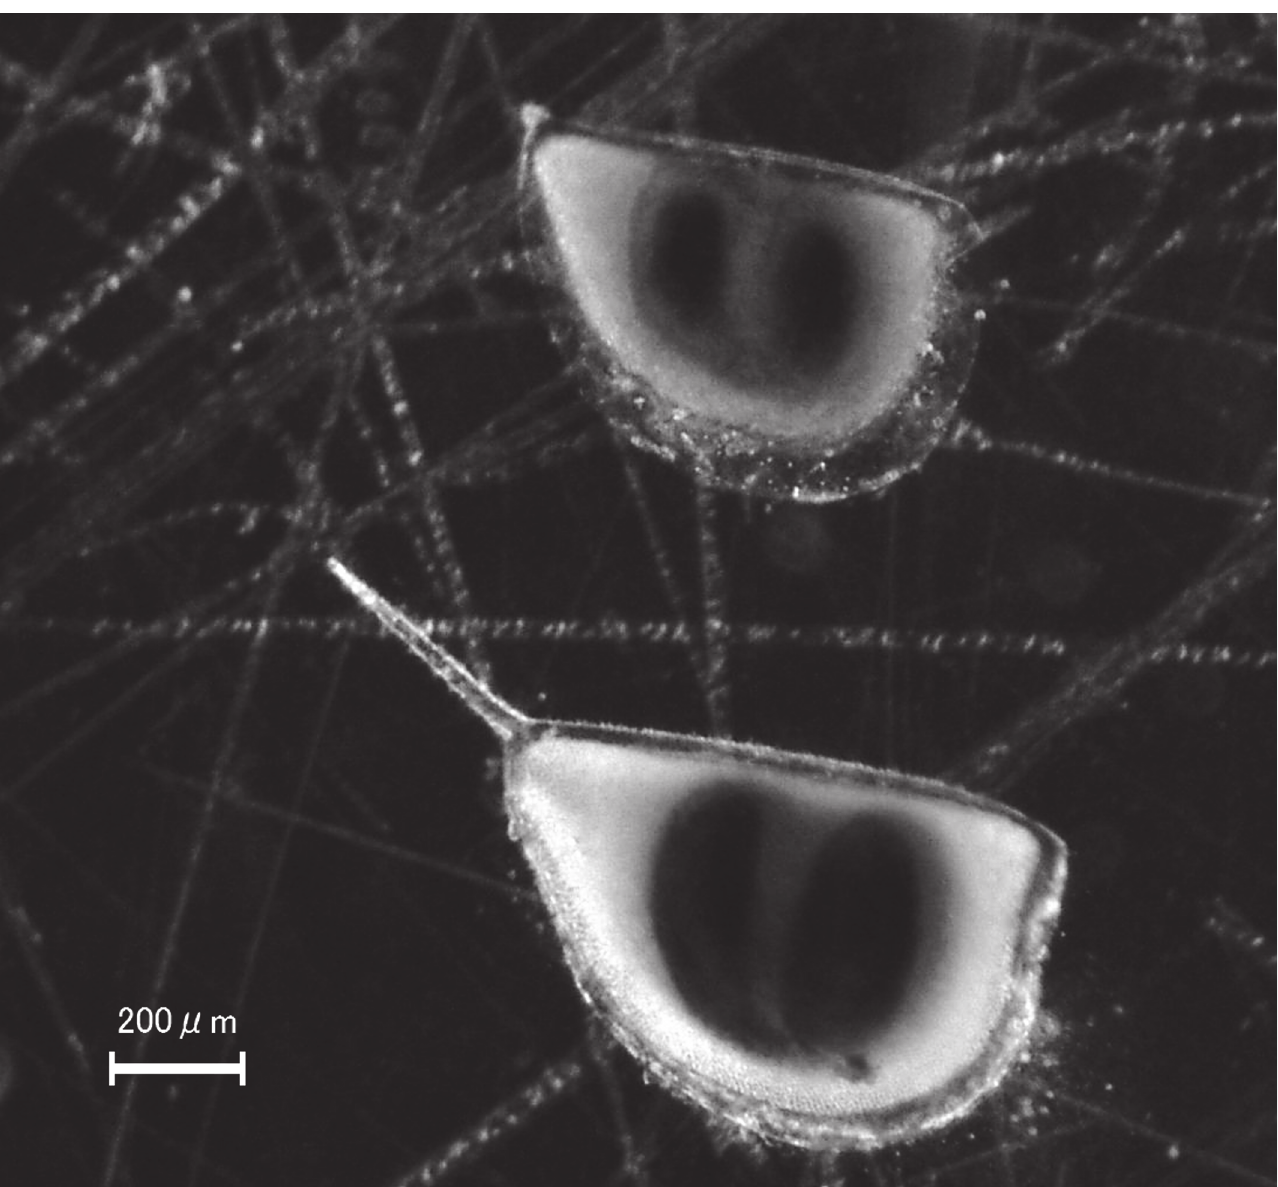
Fig 1. Photomicrograph as examples of ephippial carapaces of D . longispina group (above) and D . pulex (below) collected from sediment of Lake Hataya Ohnuma. Those carapaces were used for DNA extraction and were identified their species by genetic